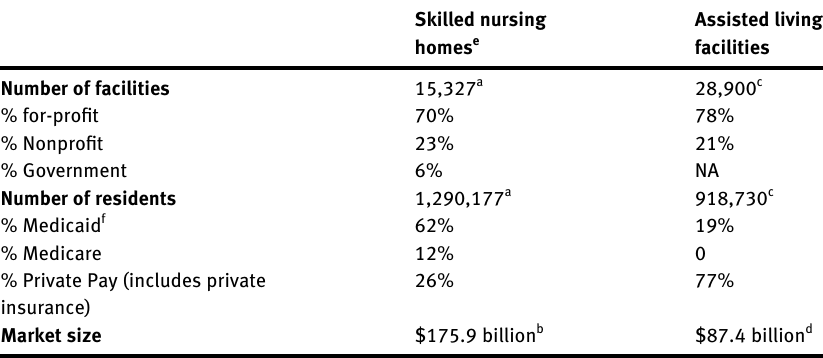
Table  : The long-term residential care industry in the United States.